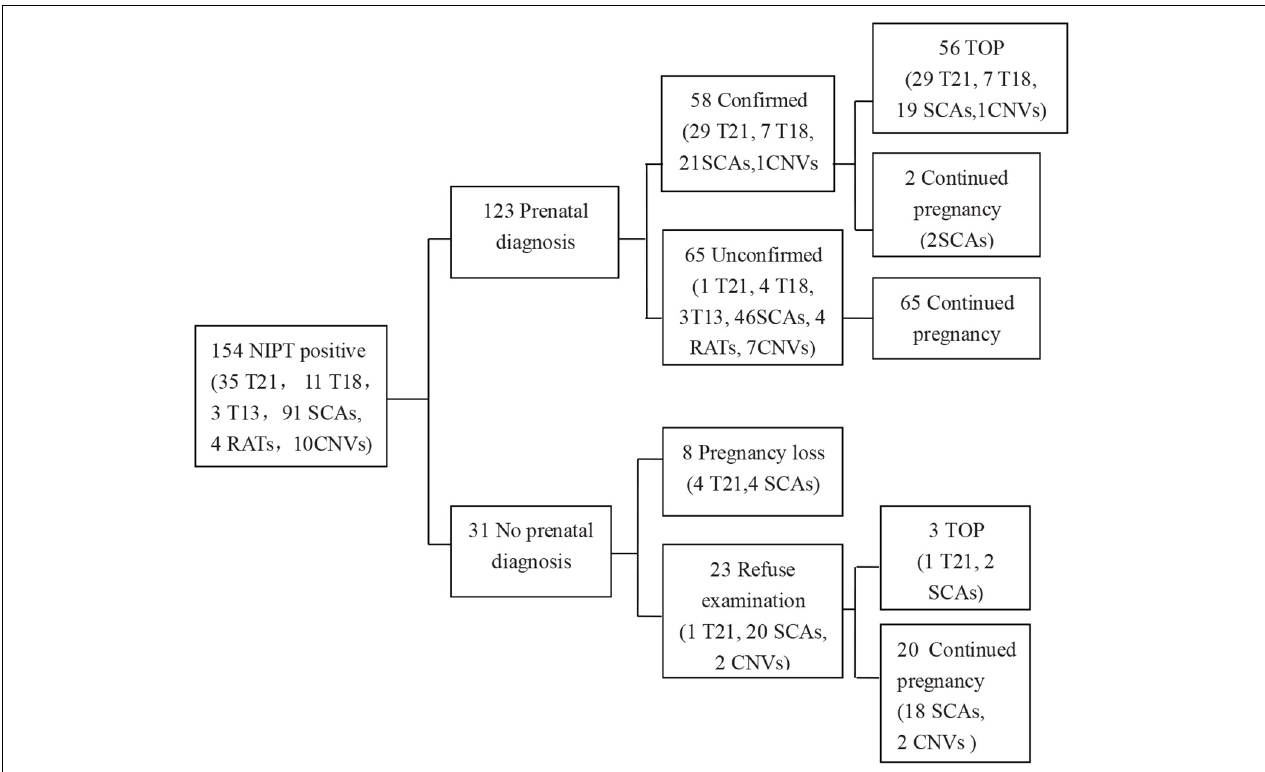
FIGURE 1 | Detailed outcome results of NIPT-positive cases. T21, trisomy 21; T18, trisomy 18; T13, trisomy 13; SCA, sex chromosomal aneuploidy; CNV, copy number variation; TOP, termination of pregnancy. Information in the brackets indicated the case numbers with different NIPT results.